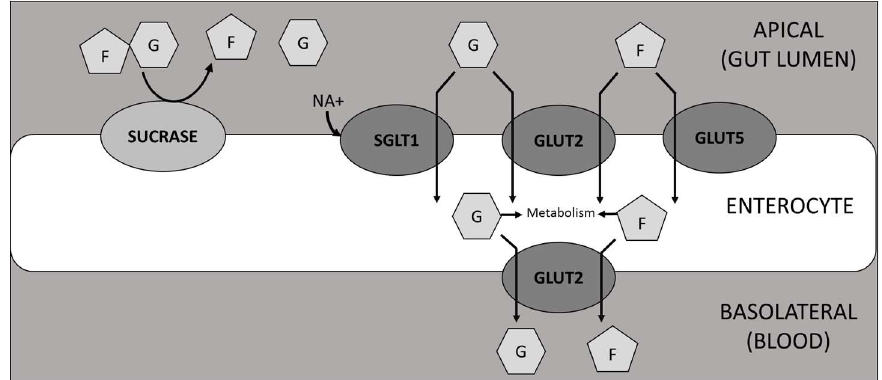
Figure 7. Diagrammatic representation of the hydrolysis of sucrose and subsequent transport of glucose and fructose through enterocytes. F = fructose; G =